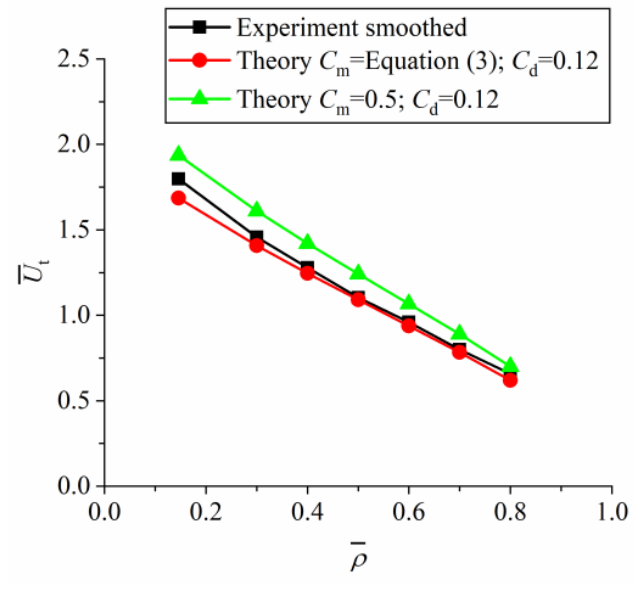
Figure 13. The dimensionless velocity of the sphere just before contacting the ice plate versus the relative density obtained by three methods with h = 0.089 and L 0 = 2.31